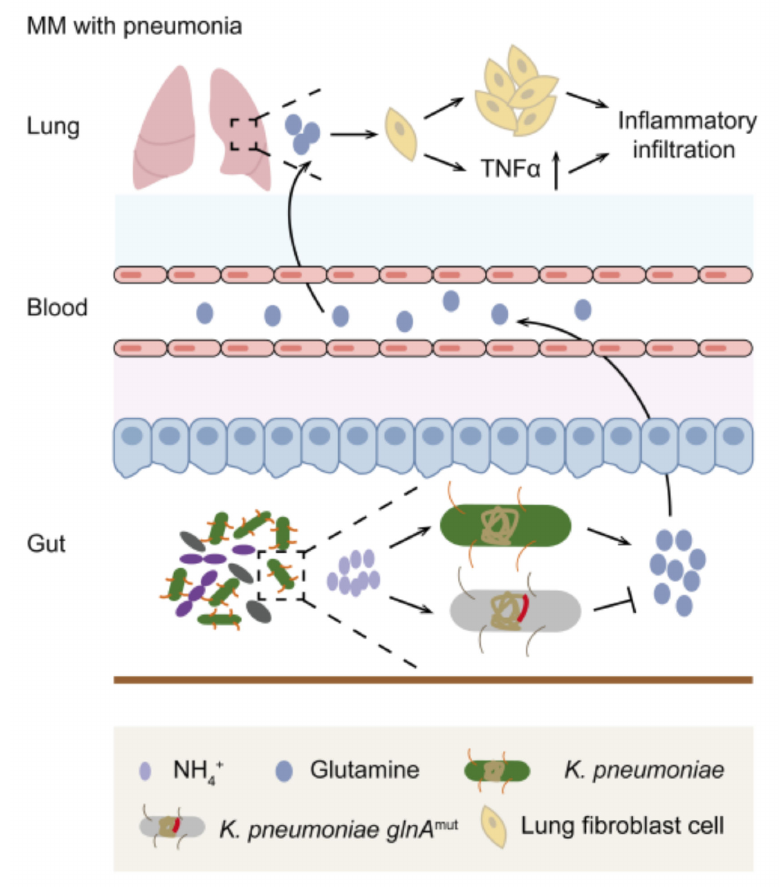
Figure 6. Schematic of working